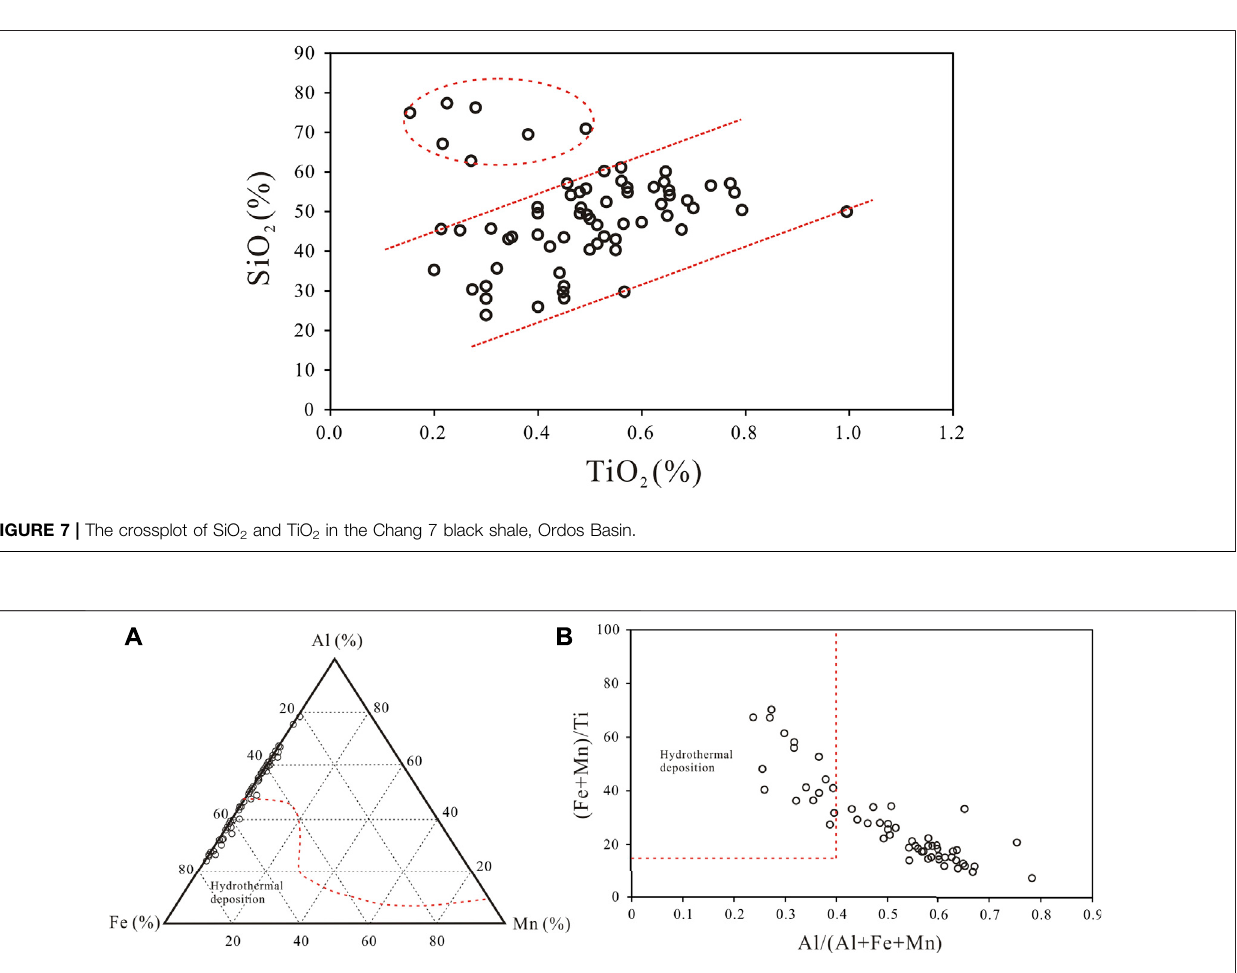
FIGURE 8 | Discrimination diagrams of hydrothermal activity based on Al, Fe, and Mn elements. Base maps are after He et al. (2016).